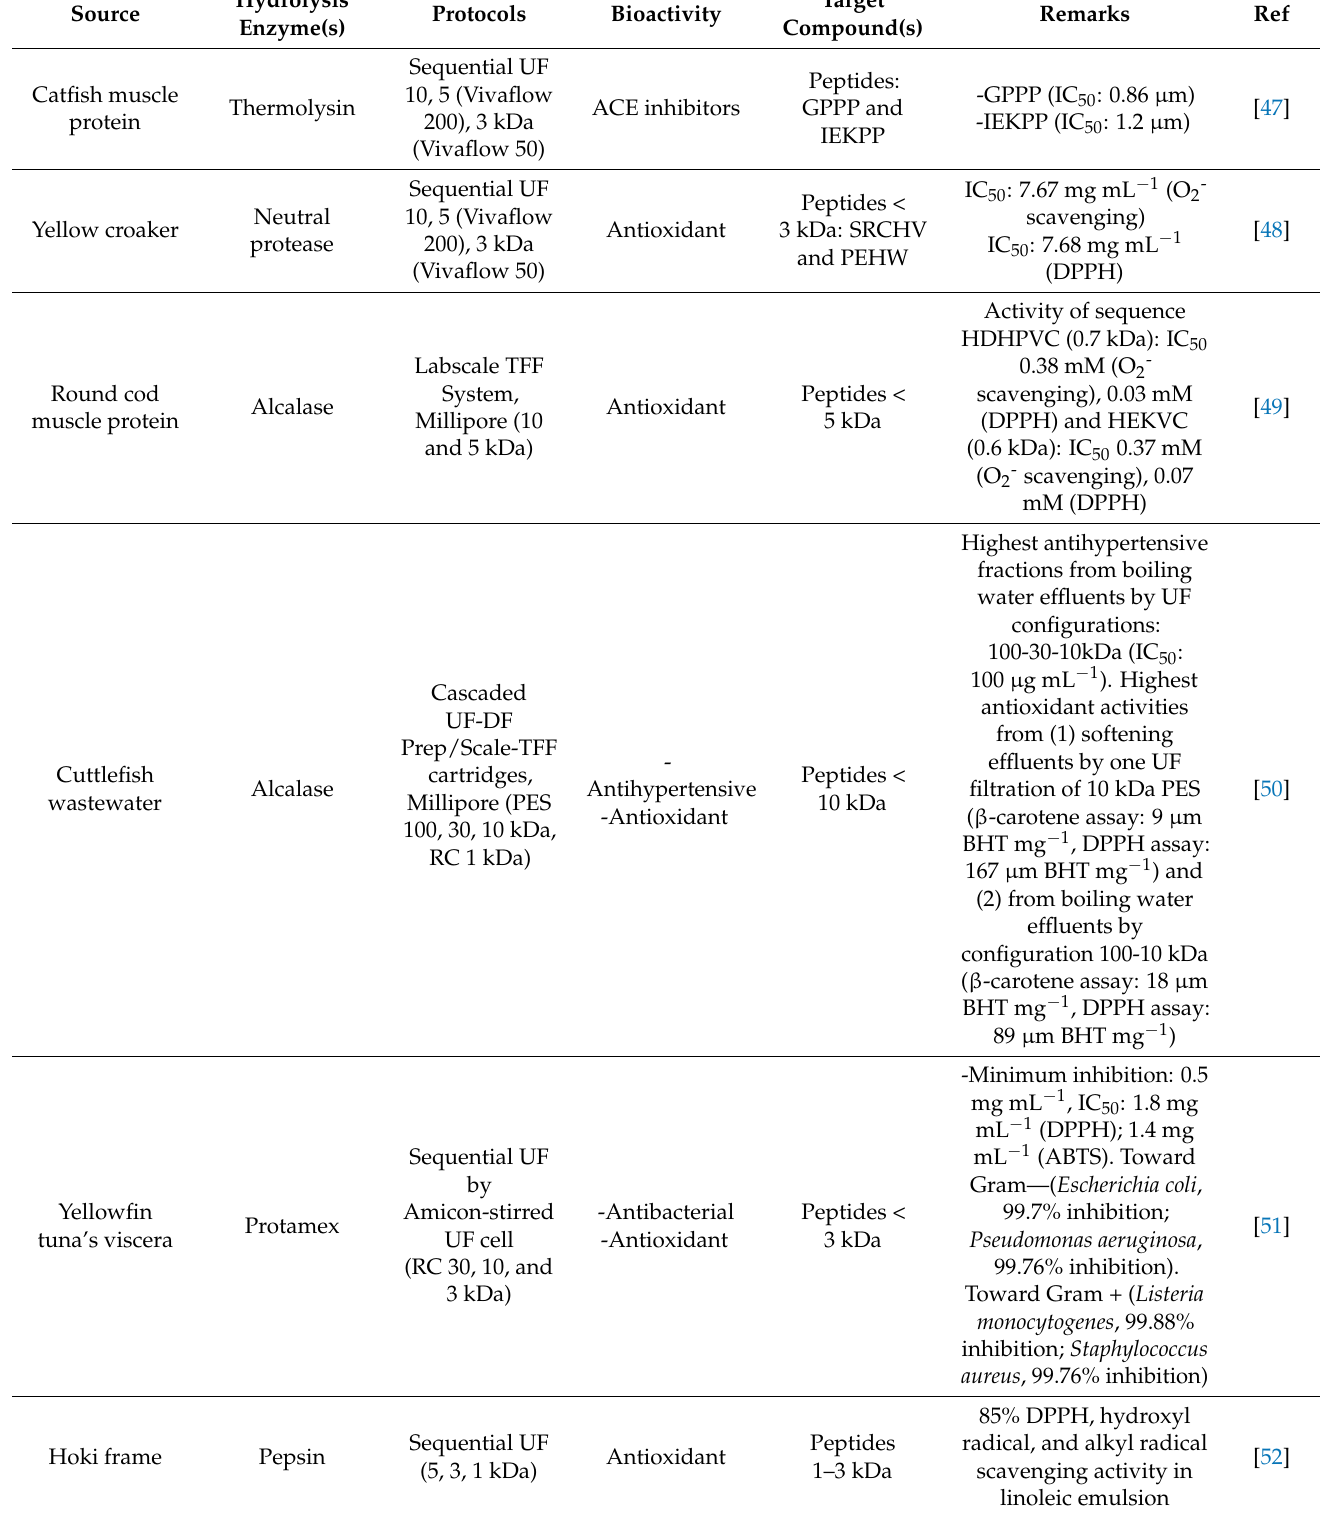
Table 2. Significant UF-assisted separation process of protein hydrolysates with expressed bioactivities from marine sources.